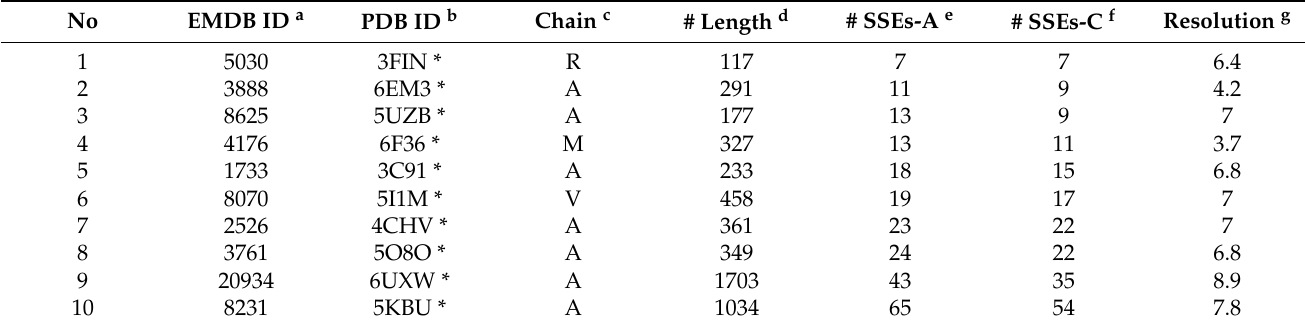
a The EMDB ID of the protein used in the test; b the PDB ID of the protein used in the test. β -containing proteins are marked with *; c the protein chain; d the number of amino acid residues in the sequence; e the total number of secondary structure elements ( α -helices and β -strands) in the atomic structure; f the total number of secondary structure elements ( α -helices and β -strands) extracted from the cryo-EM map; g the resolution of the experimental map in angstrom